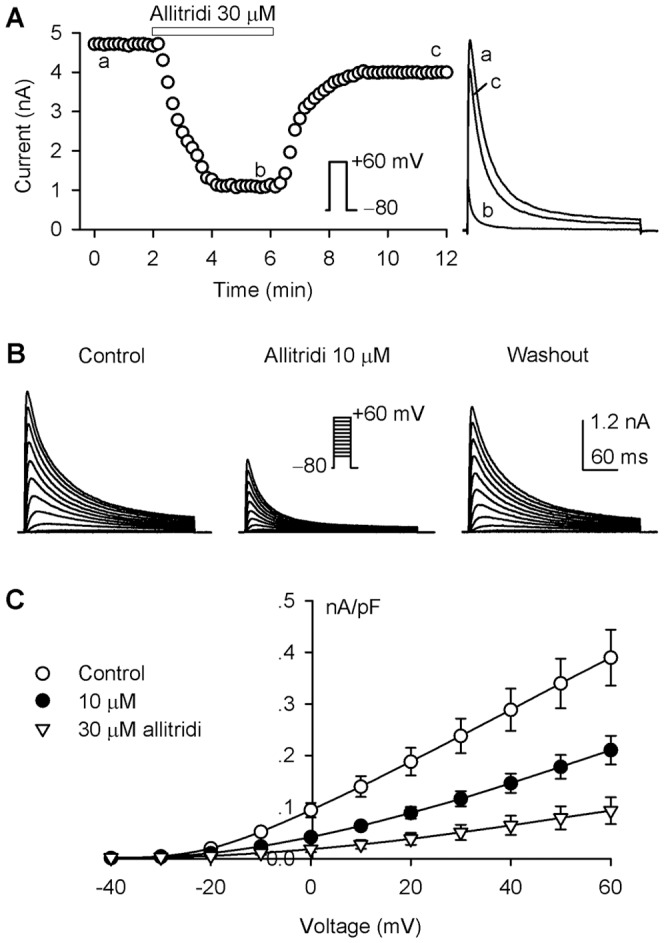
Effect of allitridi on hKv4.3 current.
A. Time course of hKv4.3 step current recorded in a representative HEK 293 cell stably expressing KCND3 gene in the absence and presence of 30 µM allitridi with a 300-ms test pulse from –80 to +60 mV (inset). Original current traces at corresponding time points are shown in right side of the panel. B. Voltage-dependent hKv4.3 current traces recorded in another cell using the protocol as shown in the inset in the absence and presence of 10 µM allitridi. C. Current-voltage (I-V) relationships of hKv4.3 current in the absence and presence of 10 and 30 µM allitridi (n = 18, P<0.05 or P<0.01 vs. control at −10 to +60 mV).